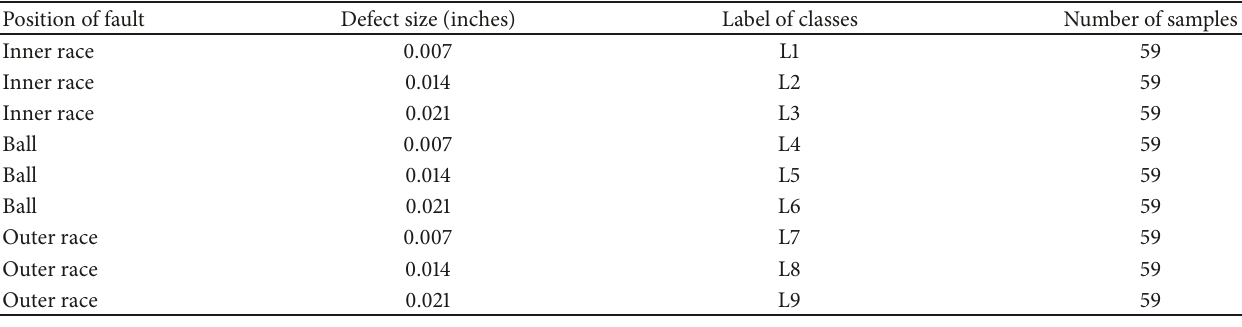
Table 1: Description of the experimental data.